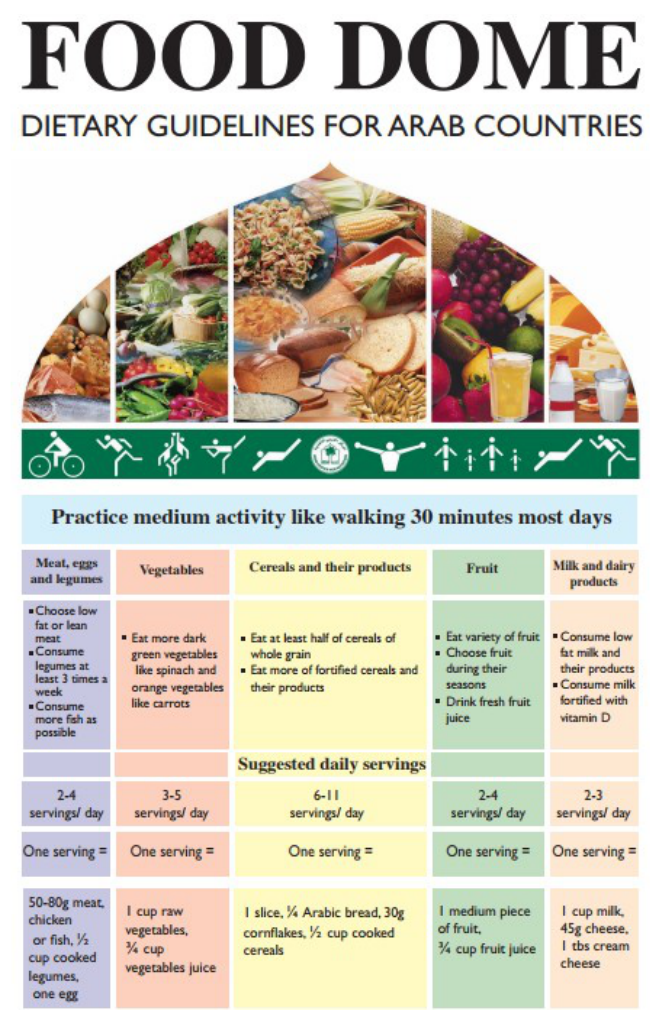
Figure 2. The Food Dome: dietary guidelines for Arab countries.